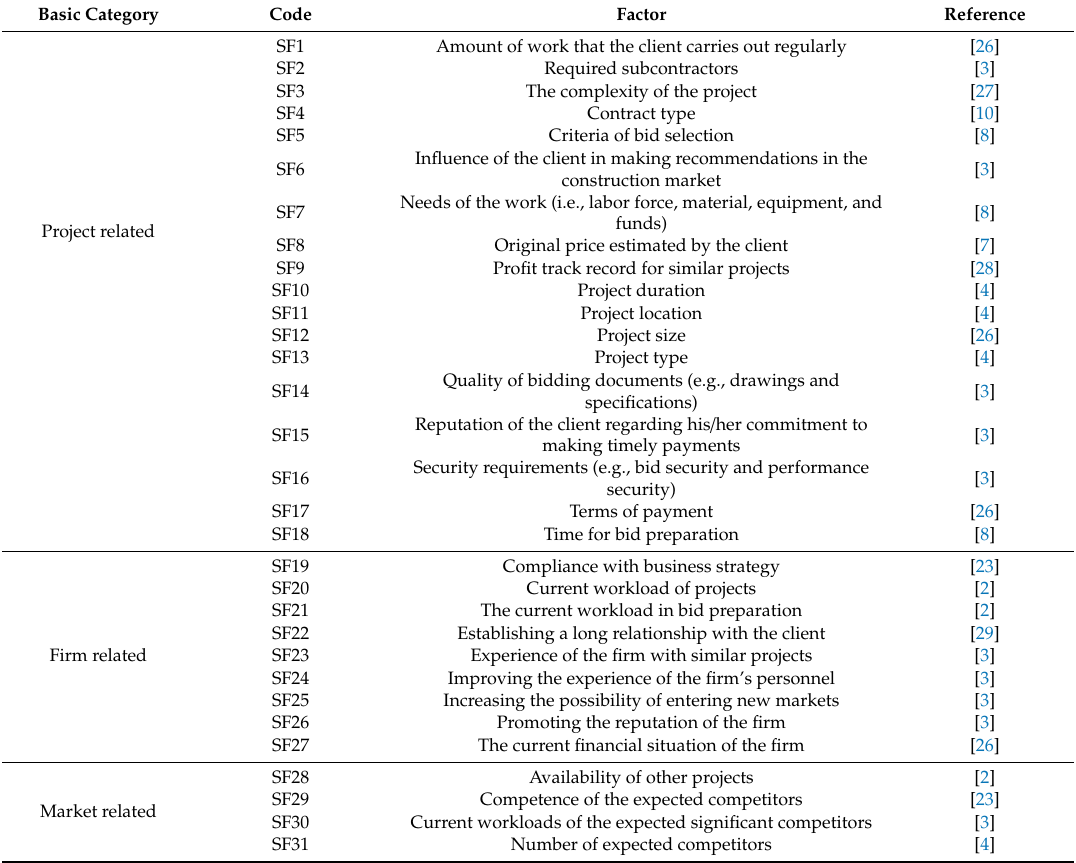
Table 1. Factors a ff ecting contractors’ BNB